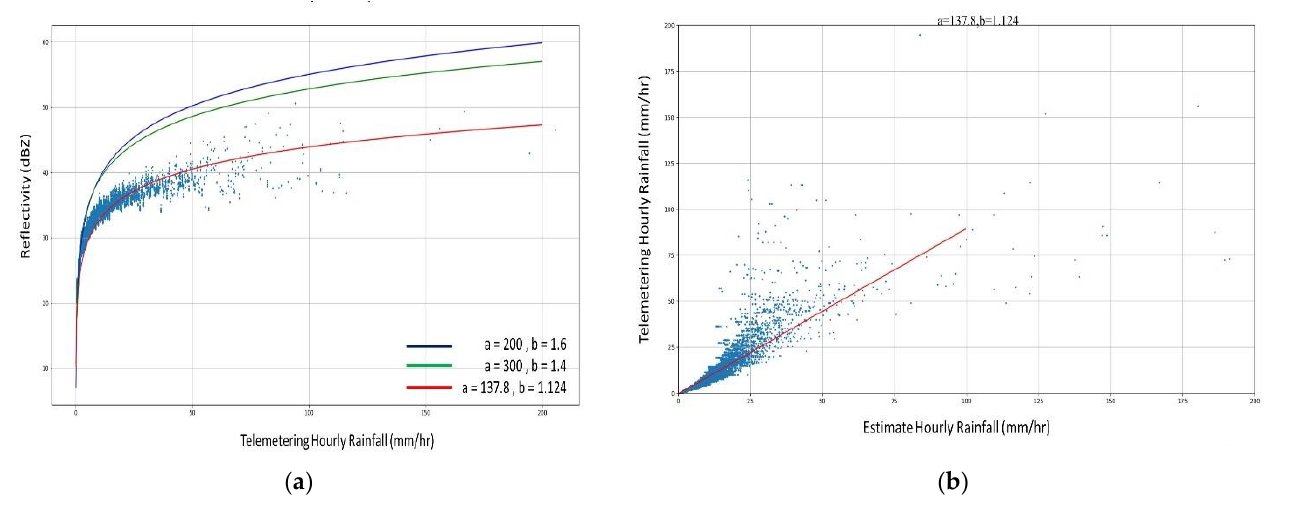
Figure 7. The relationship between rainfall rate (R) (mm/hr) and reflectivity (Z) in parabolic form. Data are for between June and September for the years 2018 and 2019. ( a ) The distribution of telemetered rainfall rate (rain gauge data) with reflectivity for Marshall Palmer Stratiform (blue line), Summer Deep Convection (green), and Linear Regression (red). ( b ) The distribution of telemetered rainfall (rain gauge data) and estimated rainfall rate based on Regression Equation, Z = 137.8R 1.124 , and radar reflectivity.